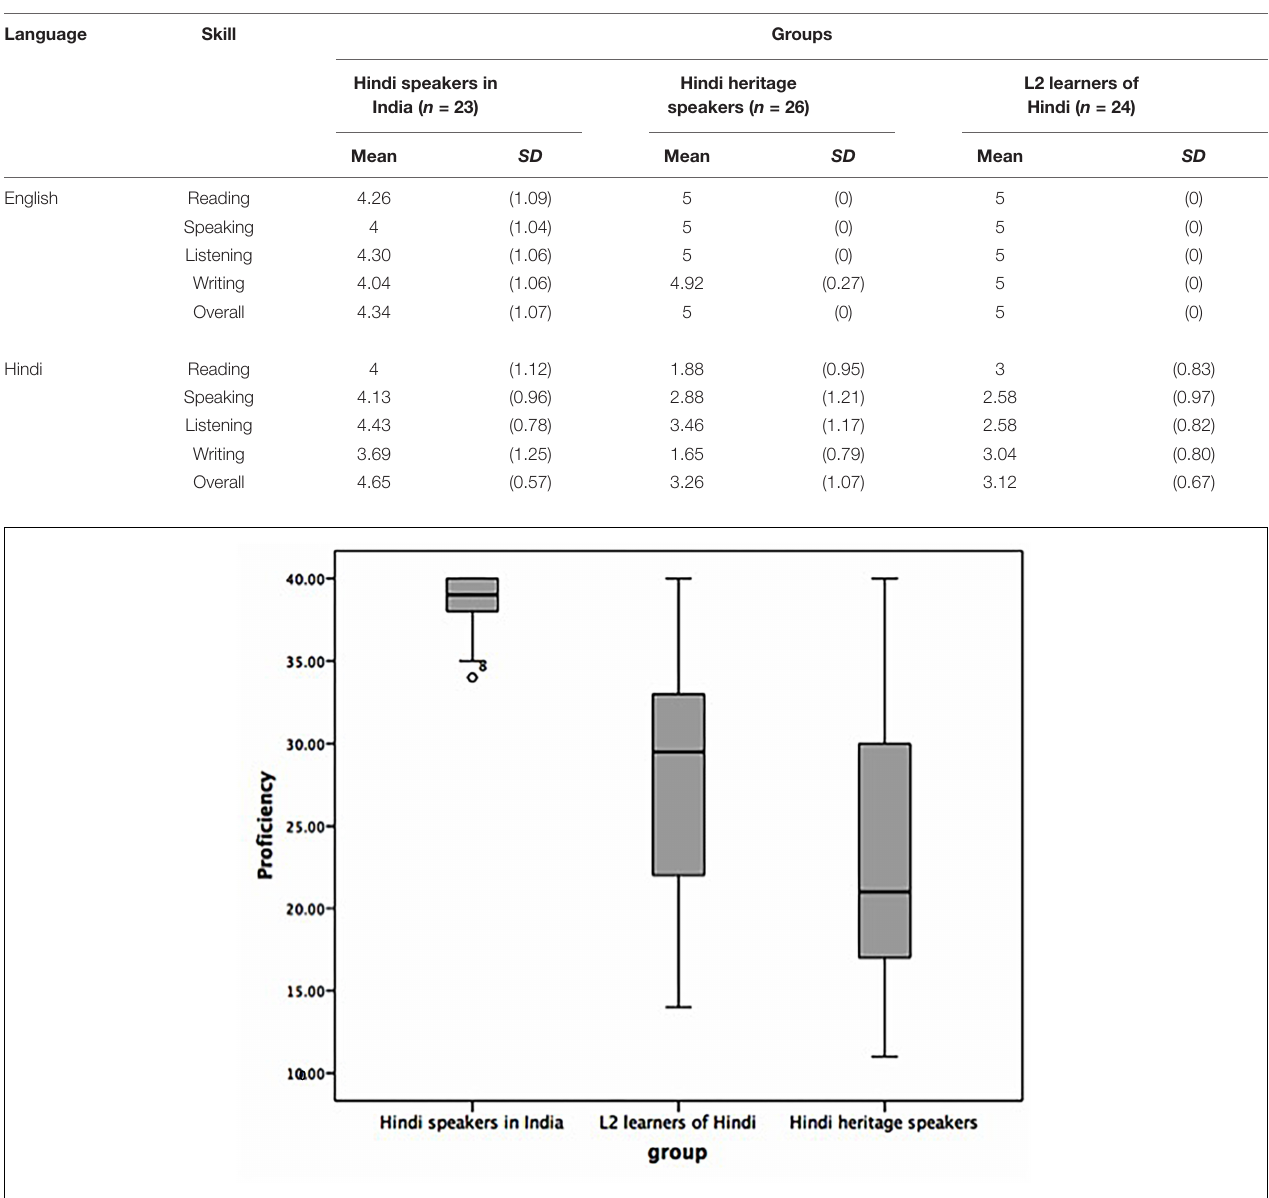
TABLE 3 | Mean self-ratings in Hindi and English language skills (1 = none-limited ability, 5 = native ability), SD s are in parentheses. Language Skill